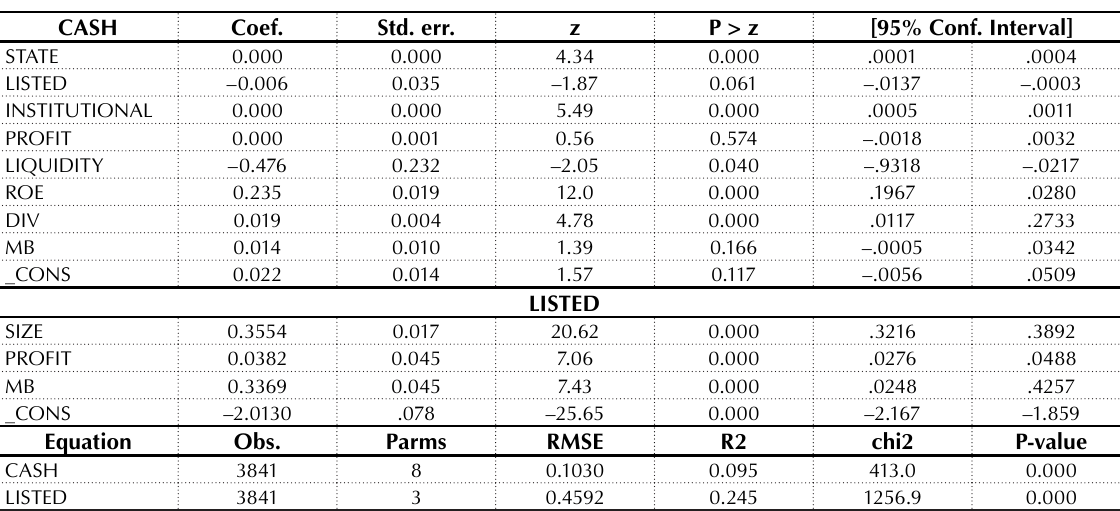
Table 5. Robust check for the impact of the prestige of stock exchanges on the cash holding